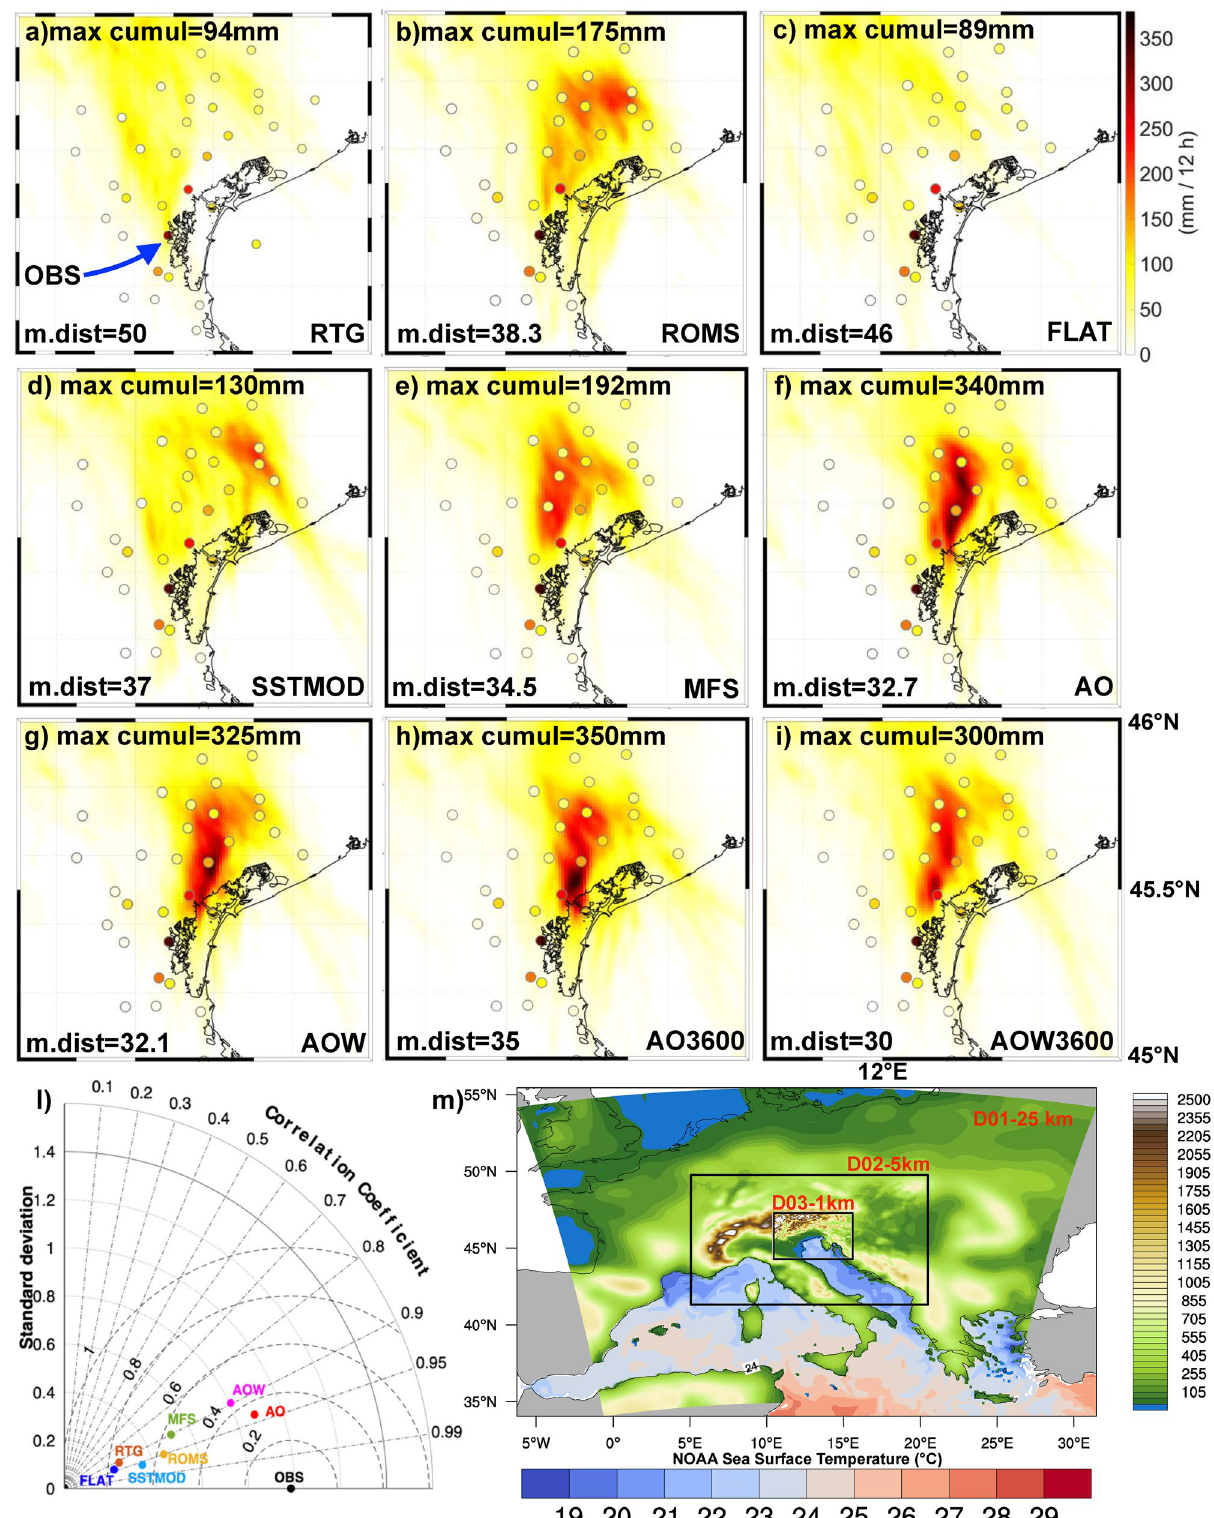
Figure 1. Panels ( a – i ) 6 h accumulated precipitation observed in each ARPAV station (coloured dots), together with simulated precipitation (mm) as resulting from the different runs. Plots refer to the period 06–12 UTC, 2007 September, 26: max cumul is the sum of maximum hourly values associated with the storm cell; m.dist is the average distance (in km) between the storm location and Campagna Lupia (where the most intense rainfall was observed and highlighted with “OBS” in panel ( a ); panel l: Taylor diagram of the timeseries of hourly rainfall maximum associated with the storm cell. Panel m shows the numerical domains, topography and satellite SST (resolution 8.3 km) at 06